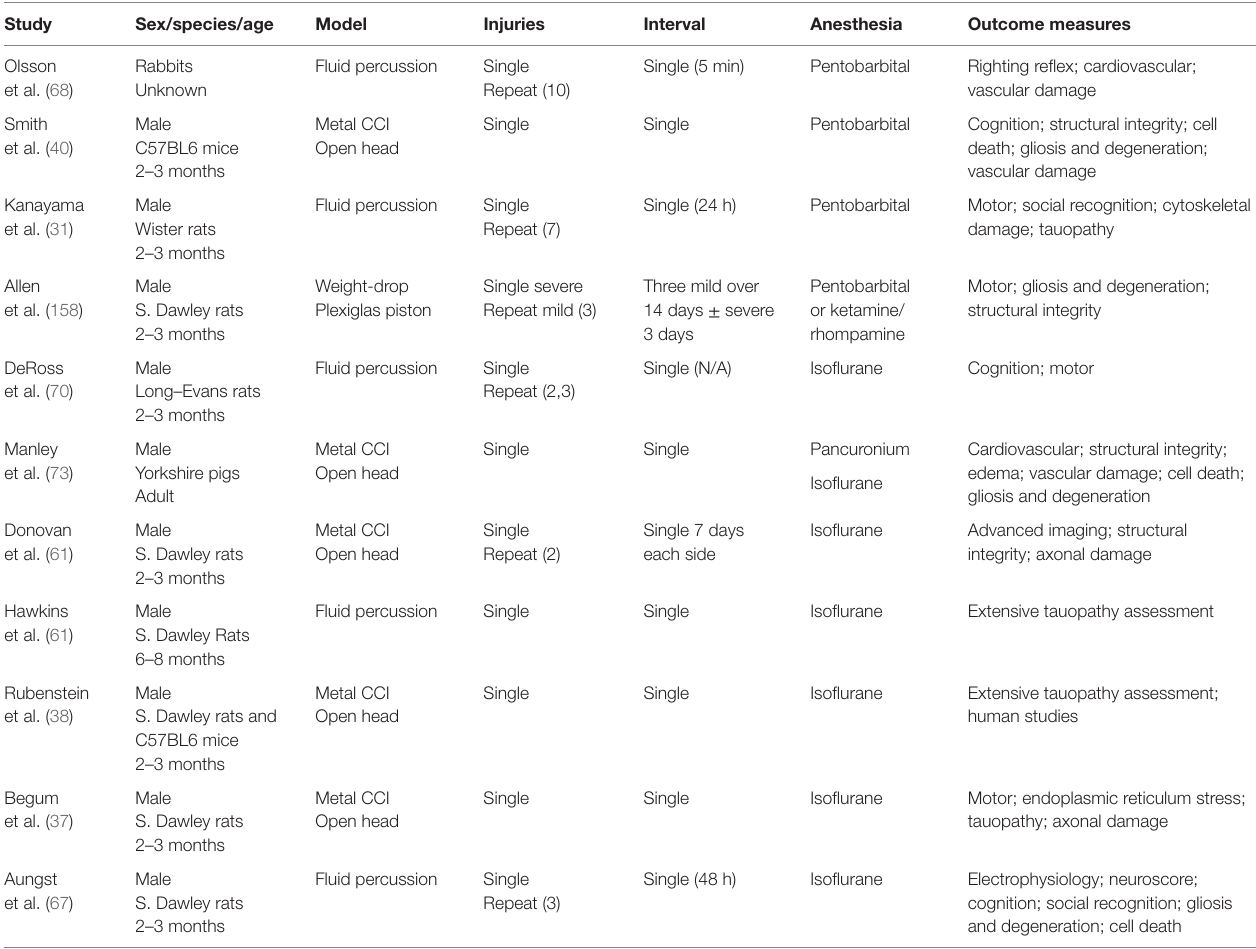
TABLe 5 | TBi models using craniotomy.